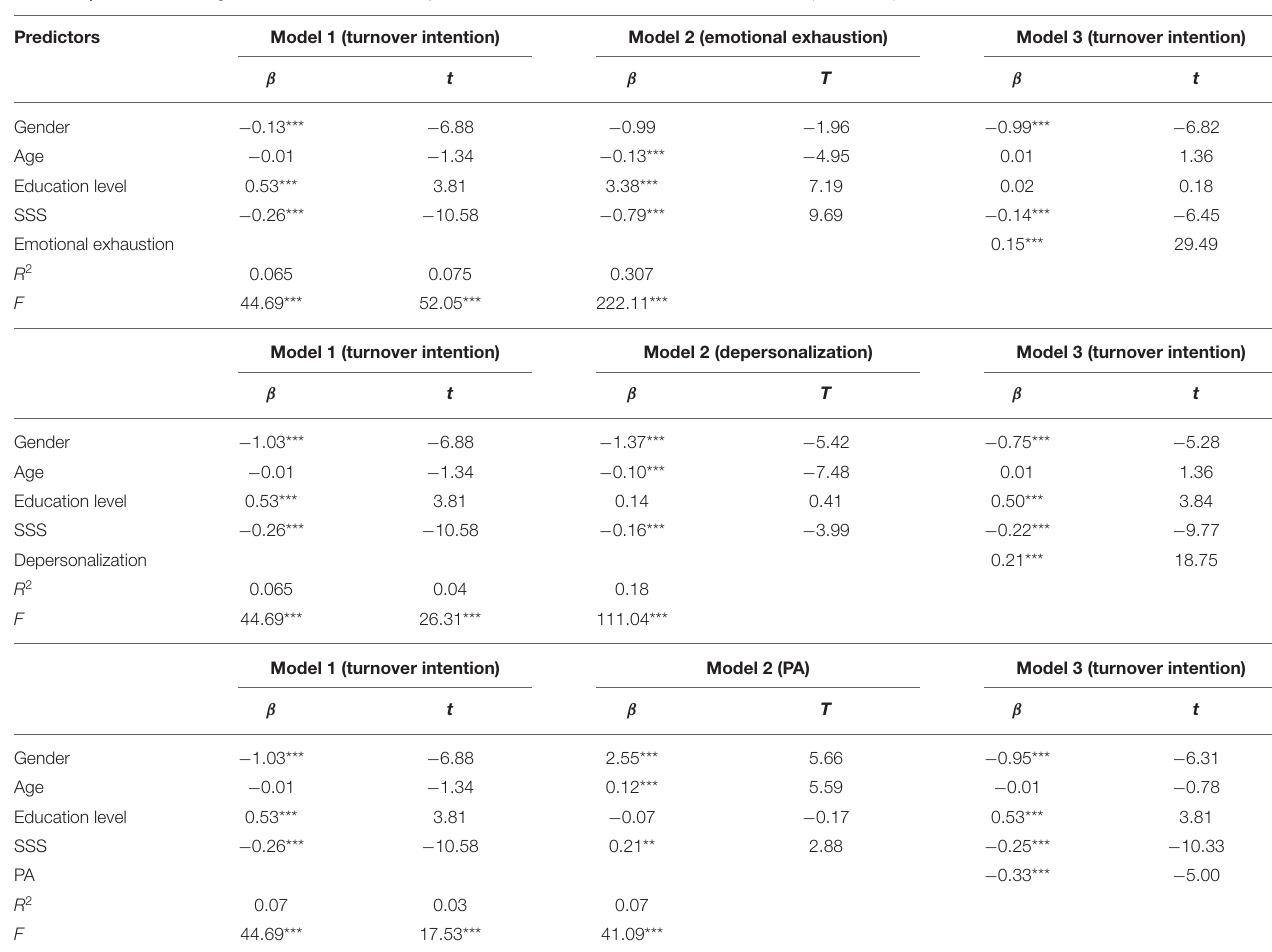
TABLE 2 | Fractional testing the mediation effect of subjective socioeconomic status on turnover intention ( N = 2,502).